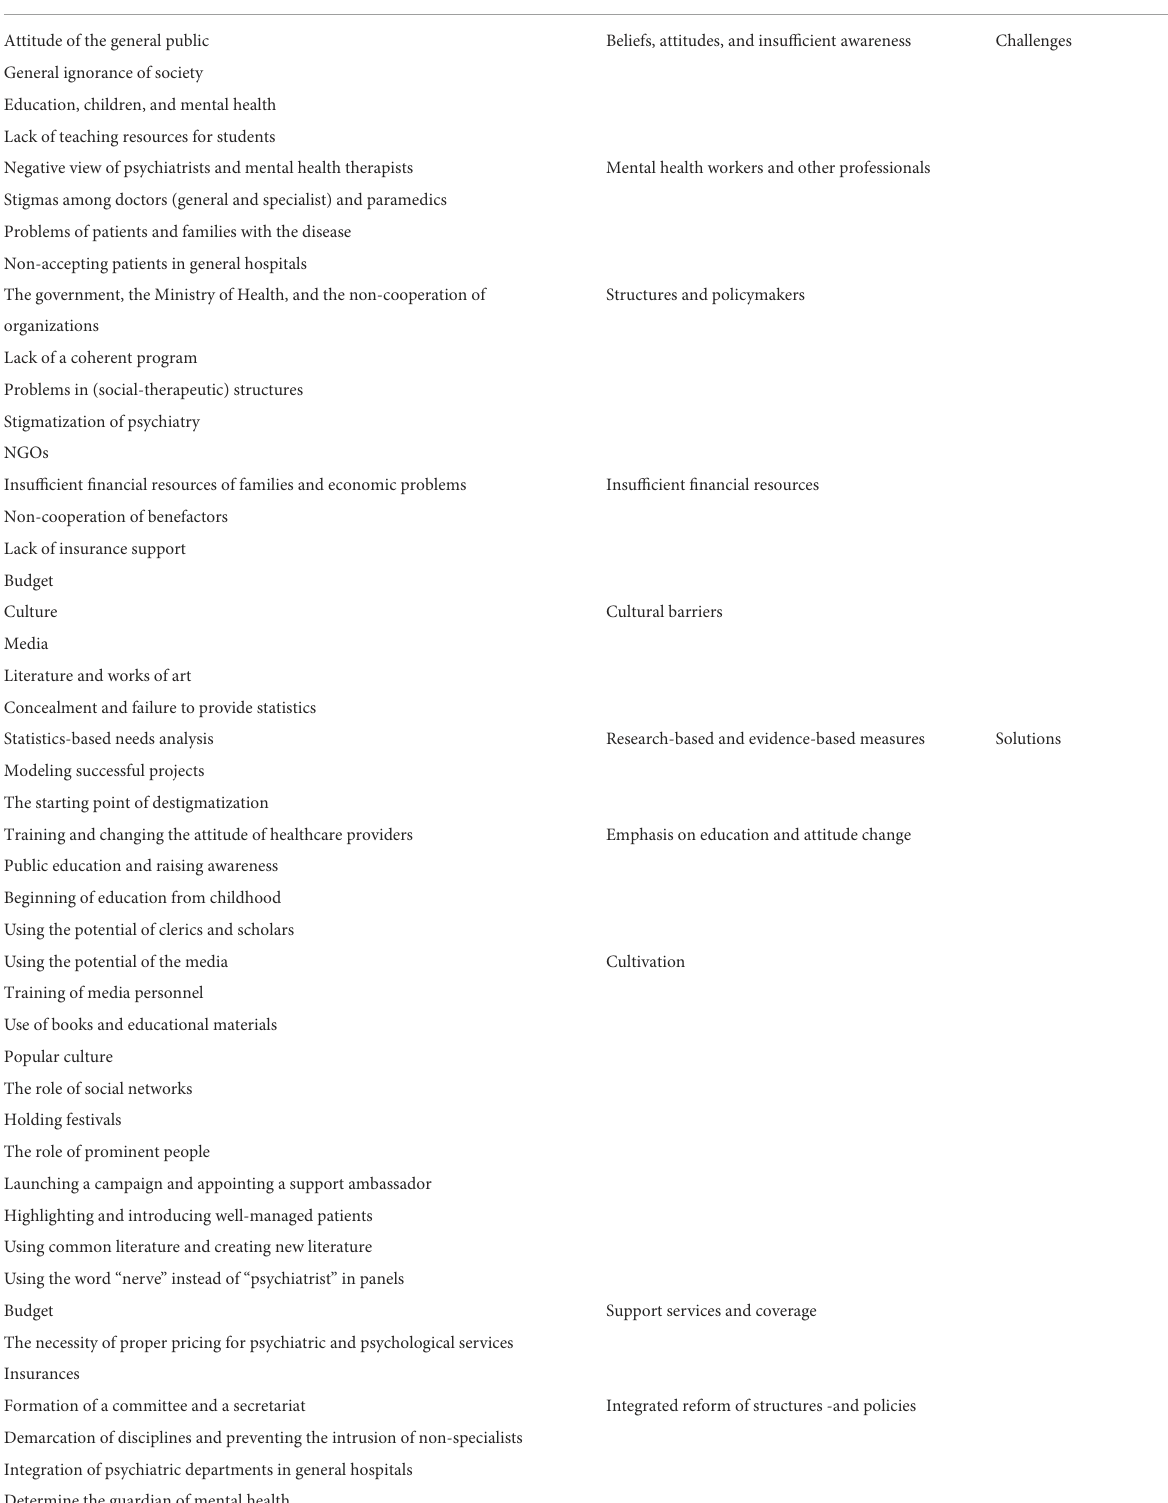
TABLE 1 Classes, sub-classes, and basic concepts extracted from the